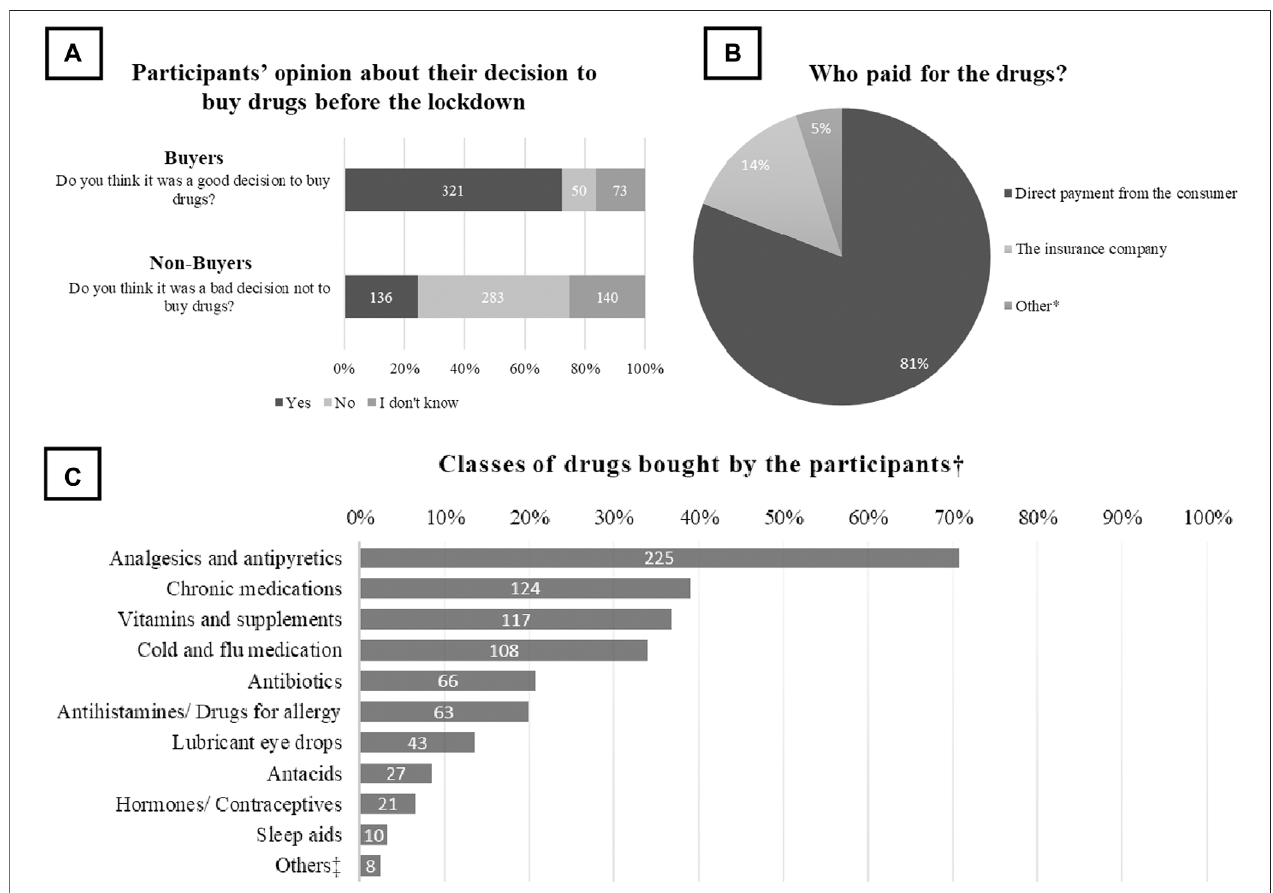
FIGURE 1 | Characteristics of participants ’ decisions. Participants were asked about (A) their opinion about the decision to buy drugs or not before the lockdown ( n (cid:1) 444buyersand559non-buyers), (B) Whopaidforthedrugstheybought( n (cid:1) 444)and (C) theclassesofdrugstheyboughtjustincasetheyneededthemduringthe lockdown ( N (cid:1) 318). *Free medical samples, government exemption of payment or medical aids, † Classes of drugs purchased by people who were not in need at the time of the purchase ‡ Laxatives, muscle relaxants and medical skin creams and ointments.